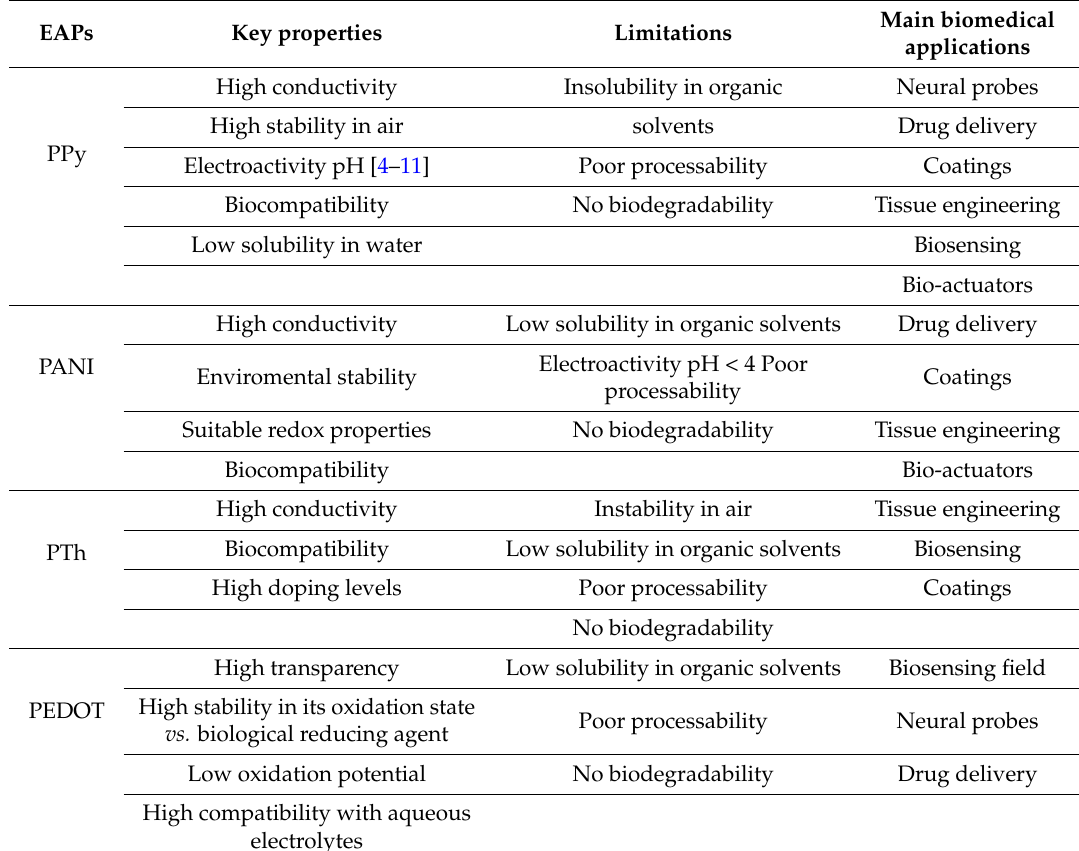
Table 2. Summary of physical/chemical features of most commonly used